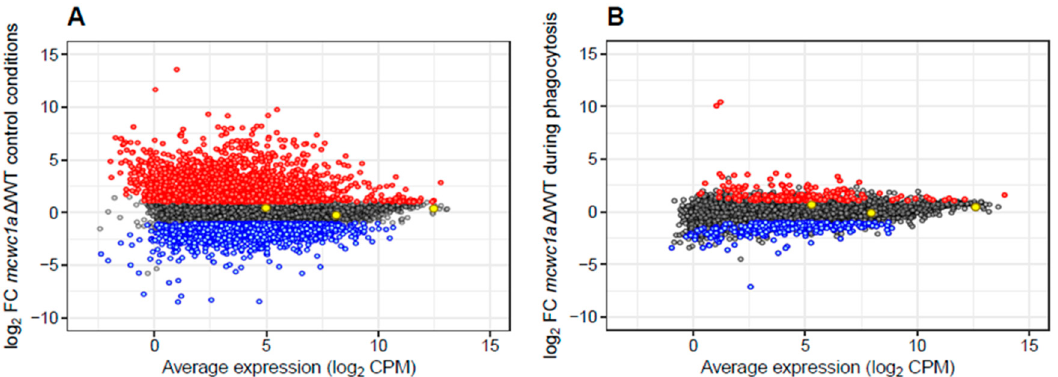
Figure 2. Scatter plots of gene expression values in the mcwc-1a Δ mutant at 5 h during regular growth ( A ) and macrophage phagocytosis ( B ) compared to gene expression in the wild-type strain. Each dot represents the expression value of any given